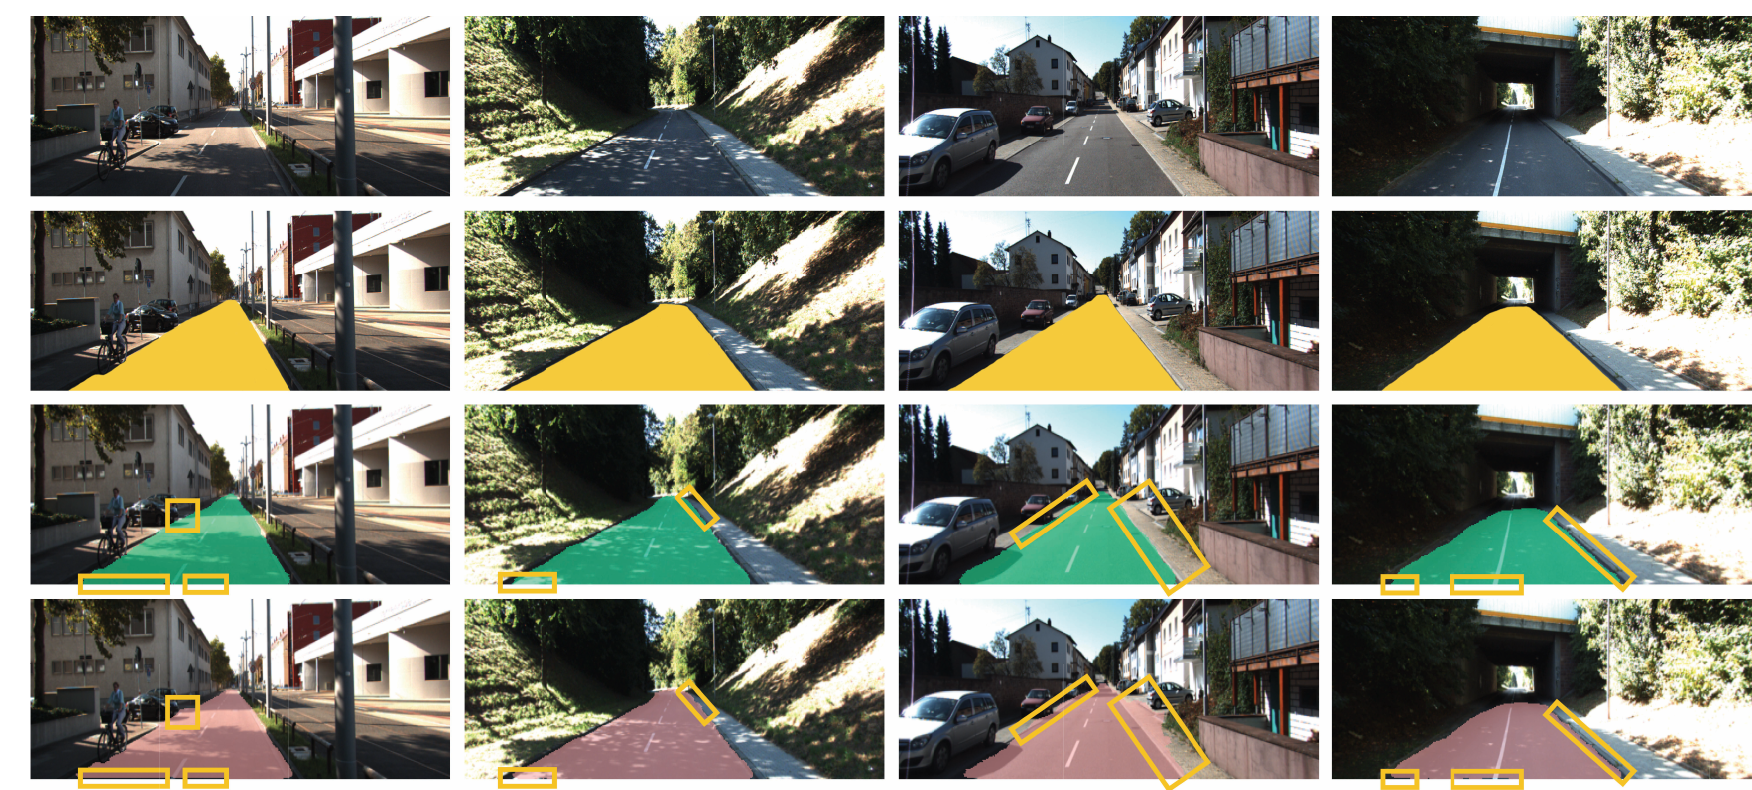
Figure 15. Results of semantic segmentation of the road. First row: some examples of road scenes in various situations. From left to right: City shadow mix scene with moving bicyclist and vehicle, back-road shadow mix with no traffic, urban city road clear sky with cars parked, tunnel dim with no traffic. Second row: the corresponding road ground truth annotations in yellow overlaid over the original image. Third row: road segmentation by our model FCNx. Row four: road segmentation by UC Berkeley